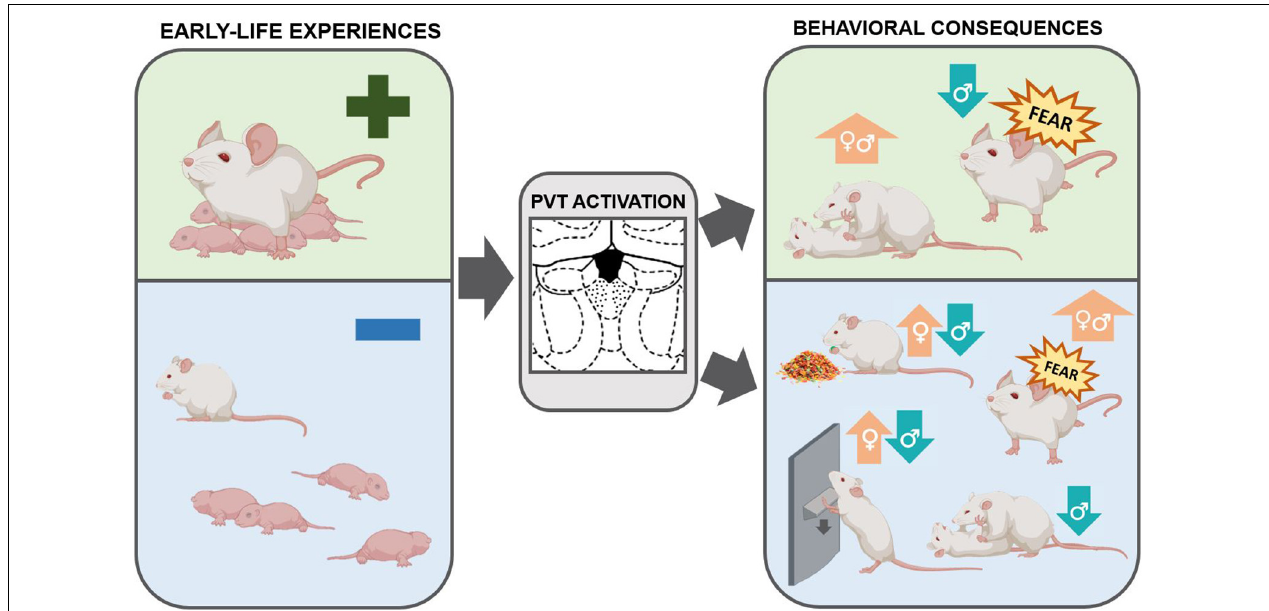
FIGURE 3 | Schematic of the relationship between early life experiences, the PVT, and consequences on adult behaviors. The PVT is engaged by emotionally-salient early-life experiences, both positive and negative. This activation may have enduring consequences in shaping behaviors later in life. Optimal early life experiences result in increased social play in both males and females and decreased fear expression in males. By contrast, ELA, as compared to control rearing conditions or optimal early life experiences, increases palatable food consumption and drug-seeking behaviors in females. ELA decreases social play, palatable food consumption, and drug-seeking in males and enhances fear expression in both sexes. These behavioral consequences may be mediated by activity in the PVT (Caldji et al., 1998; Arp et al., 2016; Molet et al., 2016; Bolton et al., 2018a,b, 2019; Levis et al., 2019; Ordoñes Sanchez et al.,